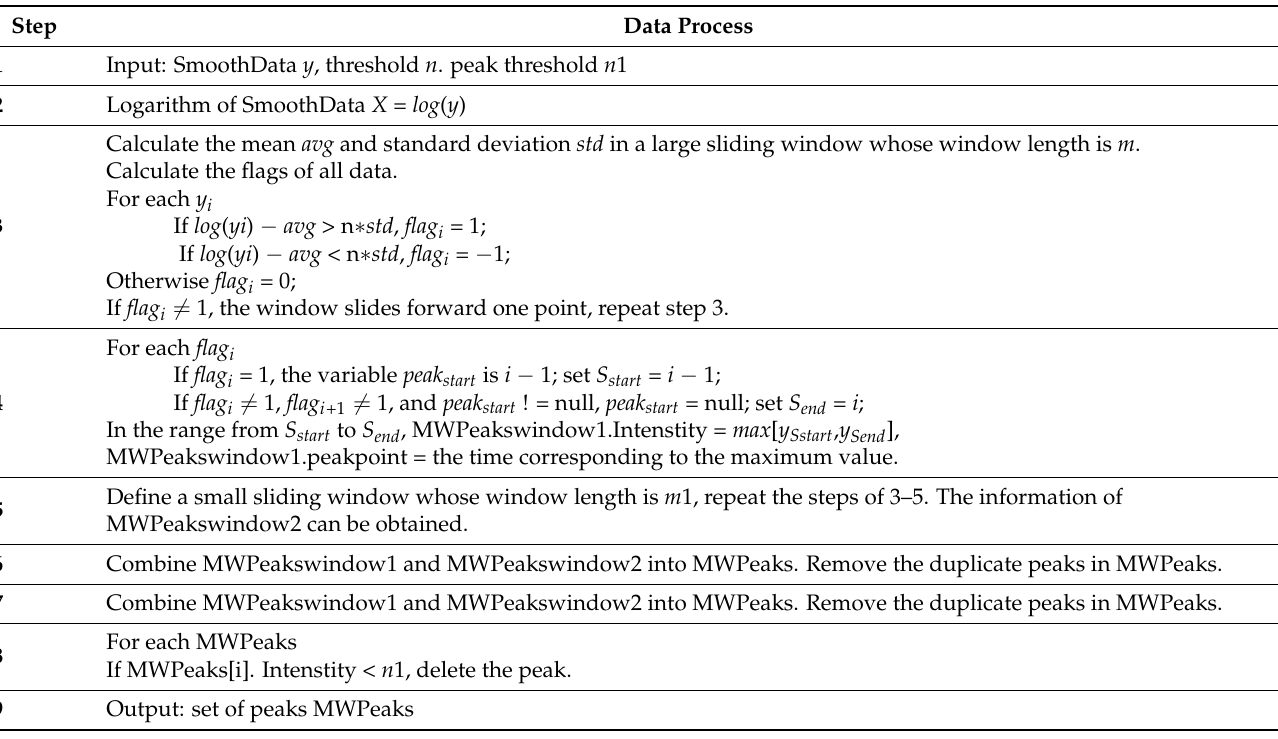
Table 1. The data process of the multi-sliding window peak identification